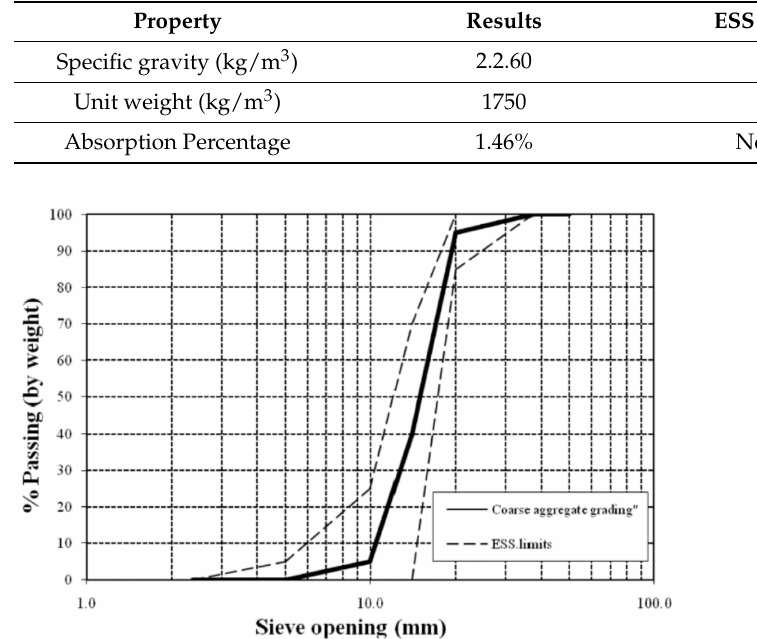
Figure 2. Coarse aggregate grading